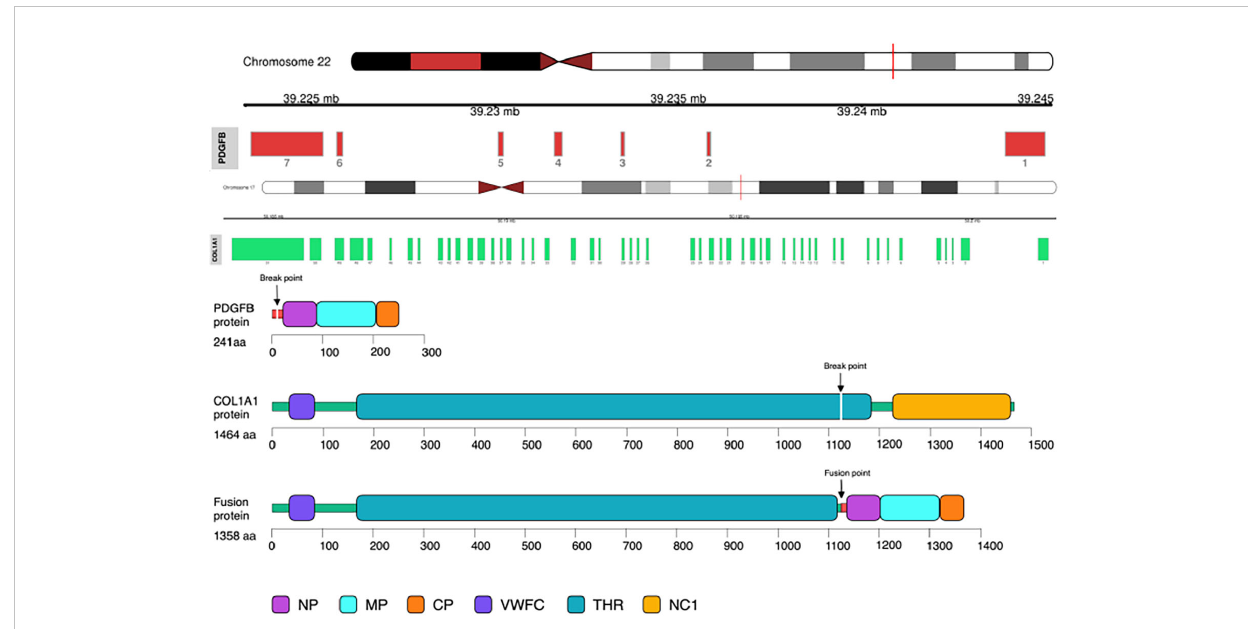
FIGURE 2 COL1A1 – PDGFB gene fusion was detected by RNA sequencing. Note the unbalanced breakpoints (arrows) on CH17q ( COL1A1 ) and 22q ( PDGFB